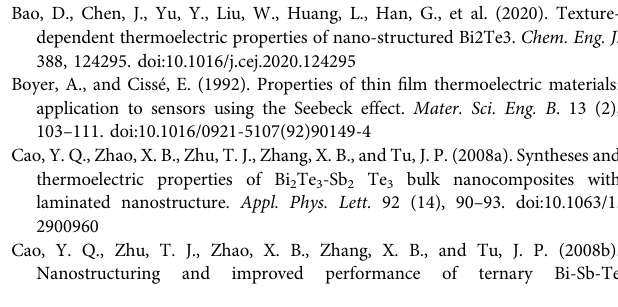
Frontiers in Materials |